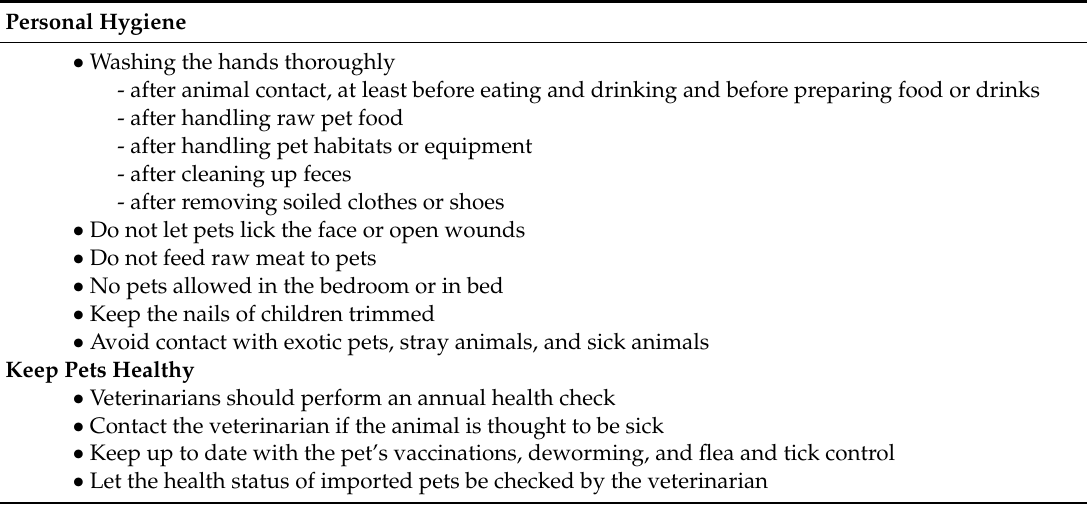
Table 1. Recommendations to prevent the transmission of zoonotic pathogens from pets [121,221]. Personal